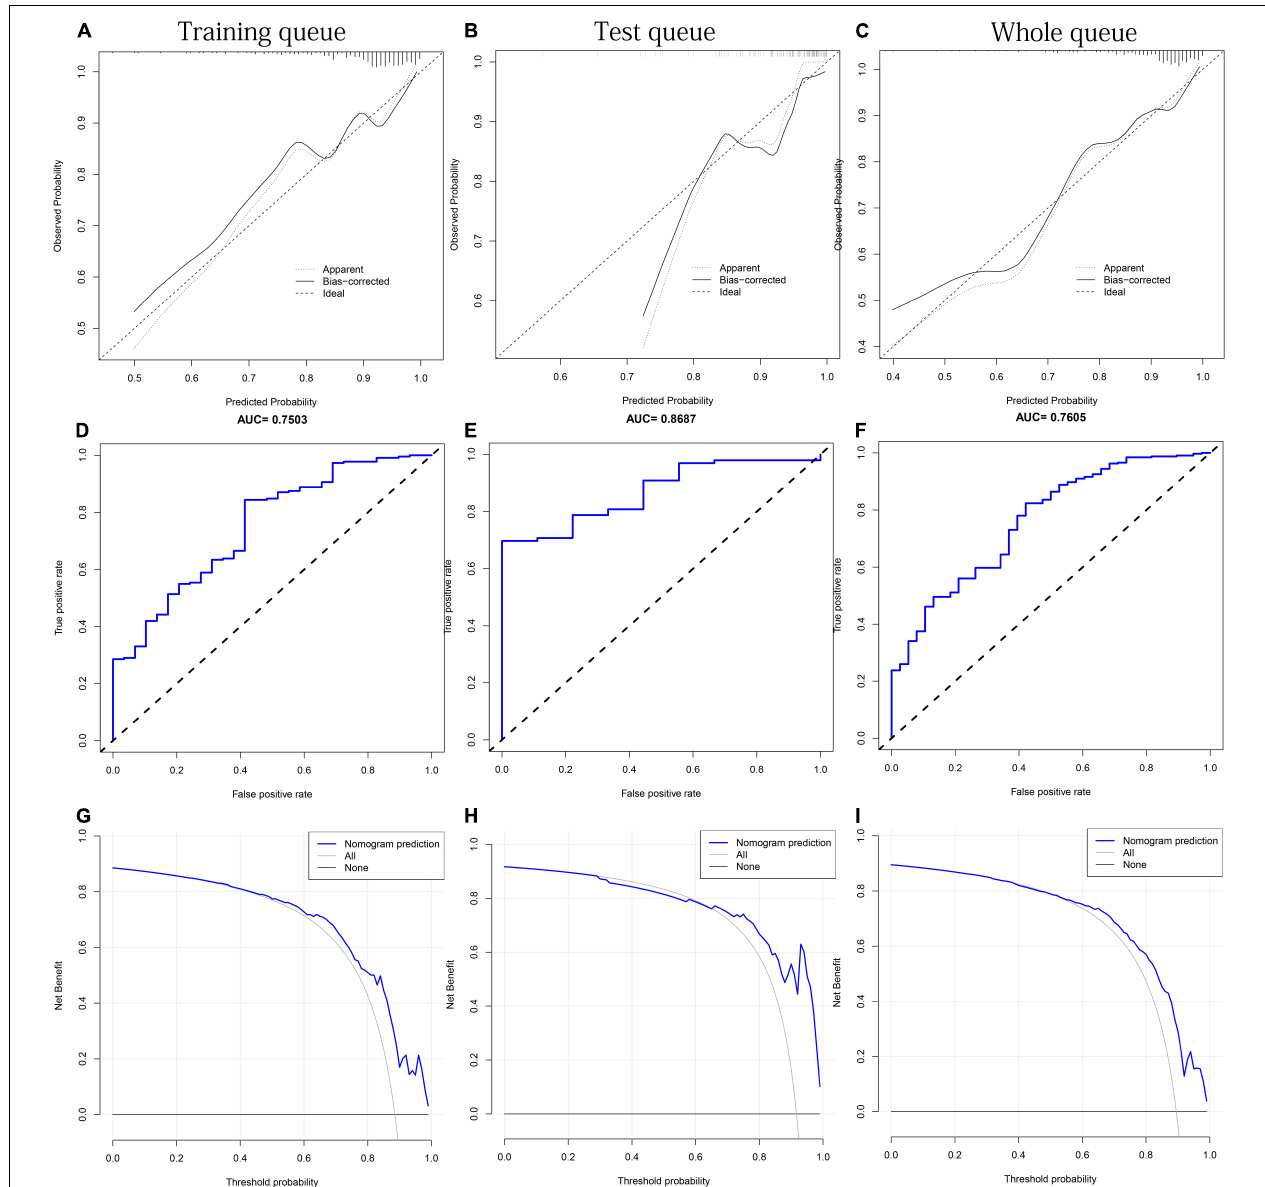
FIGURE 7 | The performance test of MFN prediction in the training, test and the whole queues, respectively. (A–C) Calibration curves. The black solid line represents the performance of the nomogram. (D–F) ROC curves. The X axis and Y axis represent false positive and true positive rates, respectively. The top of the figure shows the corresponding AUC value. (G–I) DCA curves. The blue thick solid lines represent the predictions of MFN.